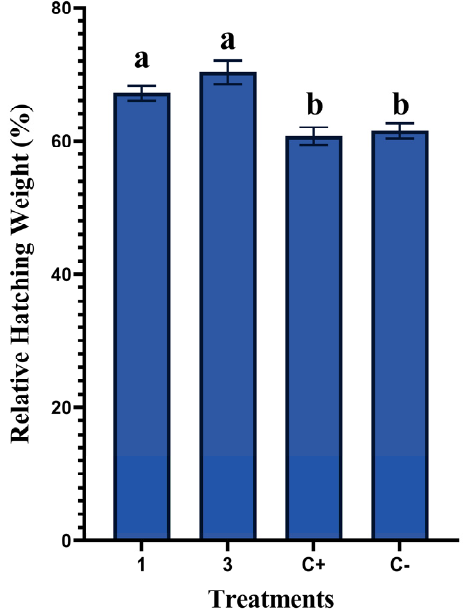
Figure 4. Effects of in ovo administration of different concentrations of rosemary essential oil on relative hatching weight in non-injected group (C − ), positive control (eggs injected with distilled water) (C+), and in treatments with rosemary EO at 1 or 3 µL/egg (five replicates/group). Different letters (a, b) indicate a statistically significant difference ( p < 0.05). Values are represented as mean ± standard error of the mean (SE).